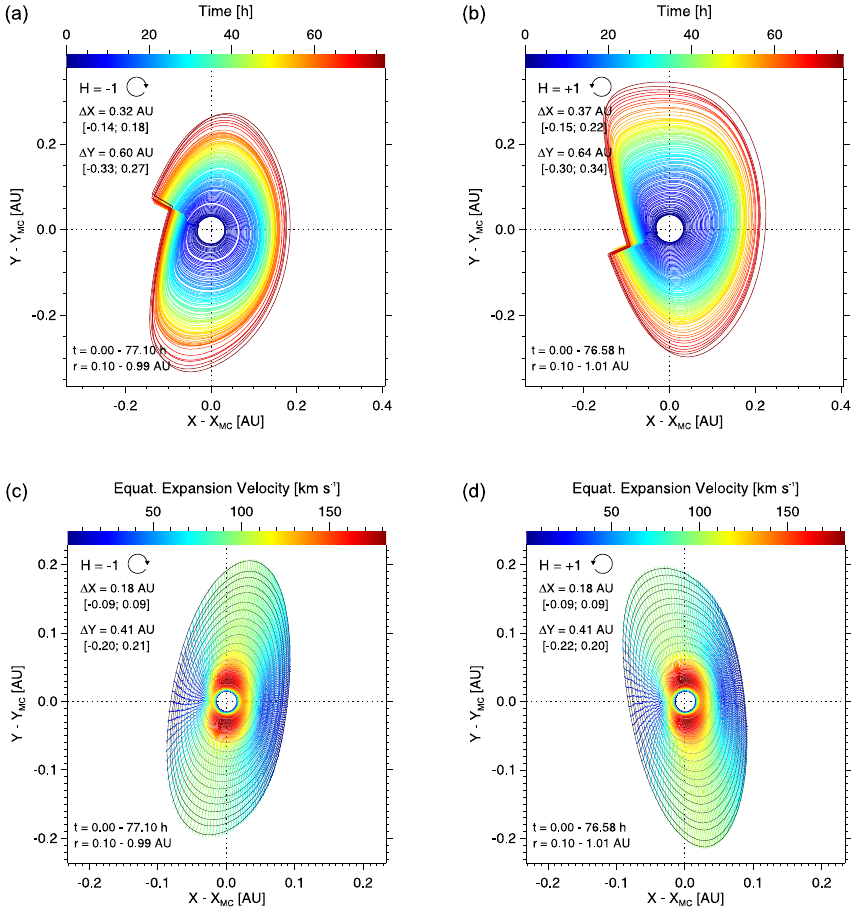
Fig. 6. Expansion of the MCs in the equatorial plane. The upper row shows the outermost “closed” magnetic field line around the MC-center at selected times of the simulation for H − e (a) and H + e (b) . The lower row illustrates the expansion of plasma inside H − e (c) and H + e (d) . The various paths of 180 test particles are plotted relative to the MC-center, and the expansion velocities, i.e., the velocities of test particles relative to the velocity of the MC-center, are color-coded along the paths. Gray contours (fluid lines) around the MC-center are drawn every